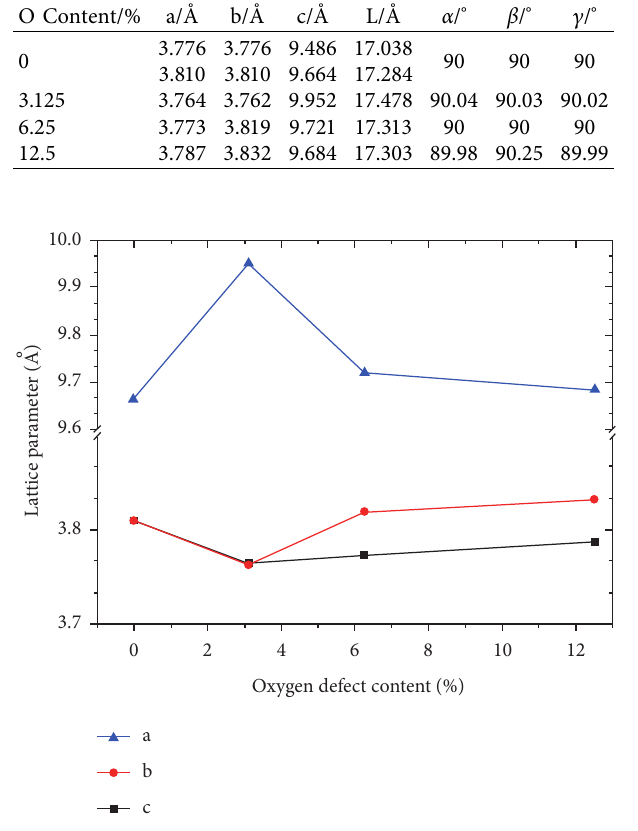
2 as a function of oxygen